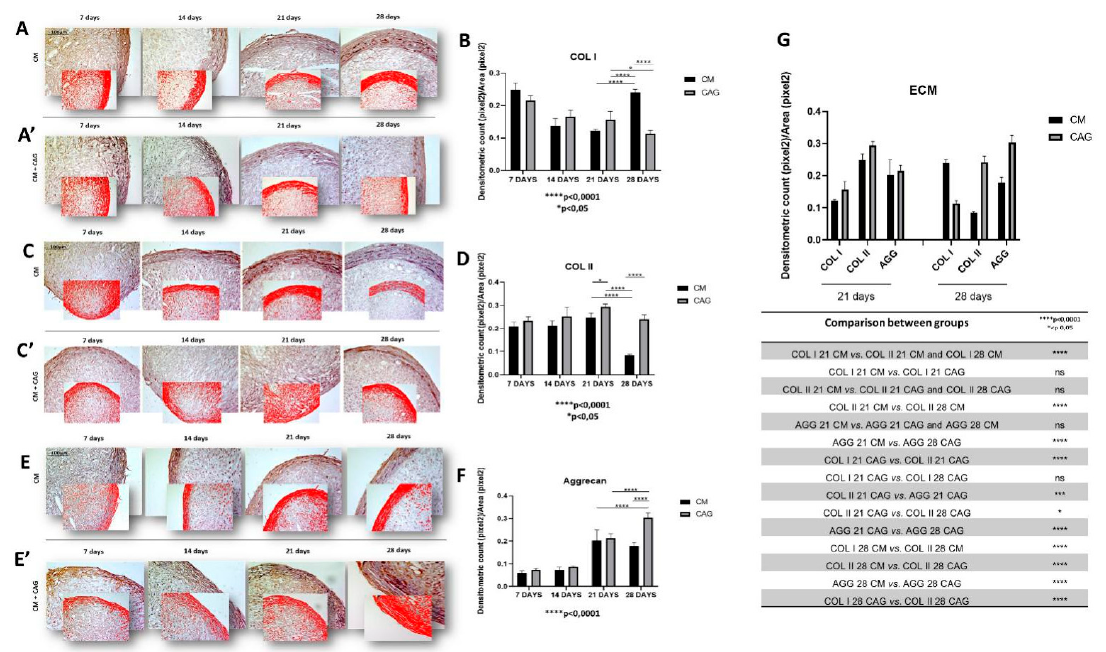
Figure 5. ( A ) Col type I, ( C ) Col type II, and ( E ) aggrecan immunohistochemical evaluation in 3D AMSC-derived chondropellets at 7, 14, 21, and 28 days of culture through computerized densitometric measurements and image analysis. ( A , C , E ) Control groups (chondrogenic medium: CM); ( A’ , C’ , E’ ) CAG-supplemented groups (CM + CAG). The smaller attached images represent the image analyses by the software: red color corresponds to brown staining (immune complexes labelled with chromogen). ( B , D , F ) Graphs representing the level of respective immunolabelings expressed as densitometric count (pixel 2 ) normalized to the area of each section expressed in pixel 2 . Objective lens, 10 × ; scale bar: 100 µ m. ( G ) Graph representing the comparison of densitometric count (pixel 2 ) of ECM components (Col I, Col II, AGG) immunolabeling identified among groups and compared between them at 21 and 28 days of 3D culture. All results were presented as the mean ± SD. ANOVA was used to evaluate the significance of the results. * p < 0.05; *** p < 0.001, **** p < 0.0001; ns, not significant. See the Materials and Methods section for details.